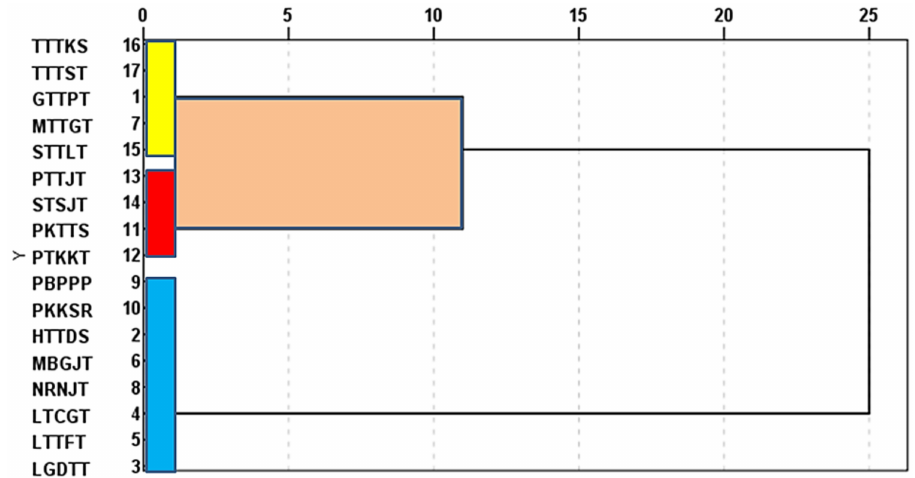
Figure 7. Dendrogram of 17 Puccinia triticina races based on the similarity in molecular